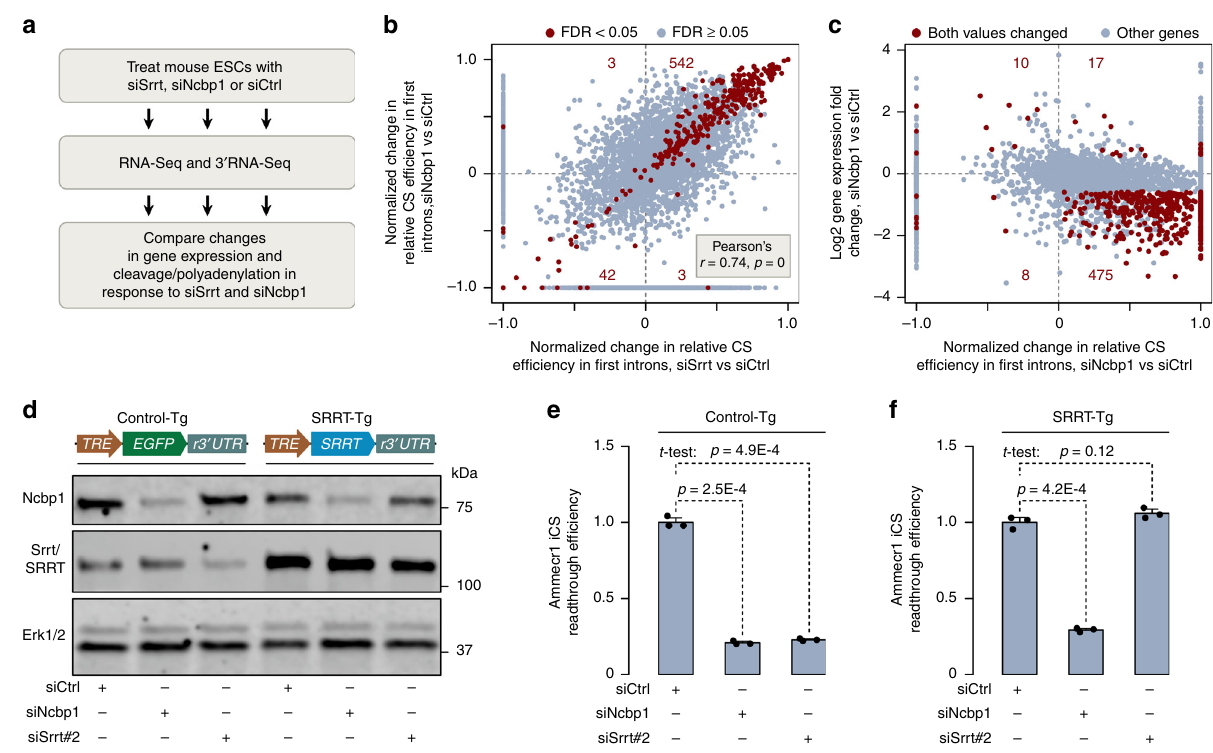
Fig. 4 Srrt-mediated repression of iCSs depends on the CBC. a Work fl ow used to compare transcriptome-wide effects of siSrrt and an siRNA targeting Ncbp1. b Scatter plot showing a correlation (Pearson ’ s r = 0.74, p = 0) between the effects of siSrrt and siNcbp1 on CSs in fi rst introns. Note that most iCSs signi fi cantly regulated by both siSrrt and siNcbp1 (FDR < 0.05; red) show an increase in relative ef fi ciency (top right quadrant). c Scatter plot showing that, similar to siSrrt (Fig. 2c), siNcbp1-mediated activation of iCSs often coincides with downregulation of corresponding genes. Red, genes with signi fi cant changes in relative CS ef fi ciency in fi rst introns (FDR < 0.05) and expression levels (FC ≥ 1.5 and FDR < 0.05). Gray, the rest of the genes. d ESCs containing a human SRRT transgene (SRRT-Tg; TRE-SRRT-r3 ′ UTR ) or a control expression cassette (Control-Tg; TRE-EGFP-r3 ′ UTR ) were pre-treated with 2 µ g/ml Dox for 24 h and transfected with siCtrl, siNcbp1, or siSrrt. Expression levels of the Ncbp1 and Srrt proteins were analyzed by immunoblotting 48 h later. Note that, compared to siCtrl, siNcbp1 and siSrrt reduce the abundance of the corresponding proteins in both transgenic backgrounds. However, the combined Srrt/SRRT expression in the SRRT-Tg/siSrrt sample still exceeds the Srrt levels in Control-Tg/siCtrl. Erk1/2, lane loading control. TRE , Dox- inducible promoter; r3 ′ UTR , recombinant 3 ′ UTR from SV40 virus. For quanti fi cation of this experiment see Supplementary Fig. 10d. e , f RT-qPCR analysis showing that e both siSrrt and siNcbp1 decrease transcriptional readthrough of iCS in the Ammecr1 gene in the Control-Tg background. f Recombinant SRRT rescues the effect of siSrrt but not siNcbp1 in the SRRT-Tg cells suggesting that Ncbp1 is essential for Srrt-mediated repression of iCSs. Data in e , f were averaged from three experiments ± SD and compared by a two-tailed t -test. Source data are provided as a Source Data fi